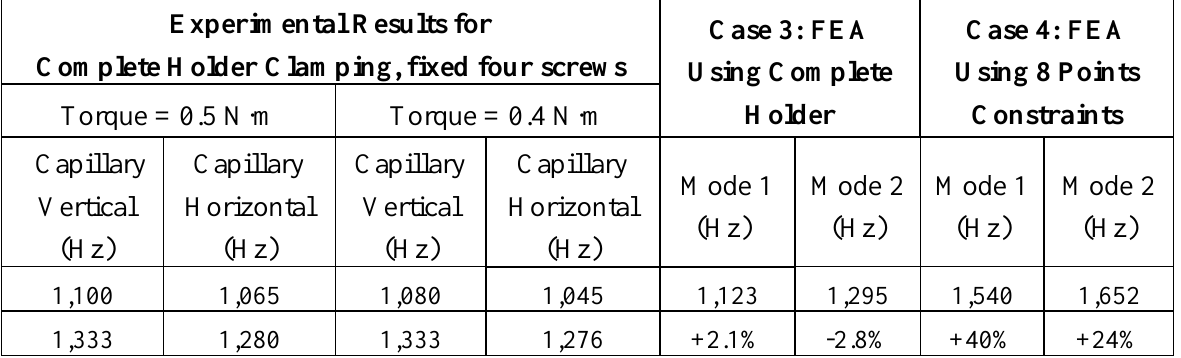
Table 4. Comparison of results for transducer with steel horn (holder diameter 11.0 mm).